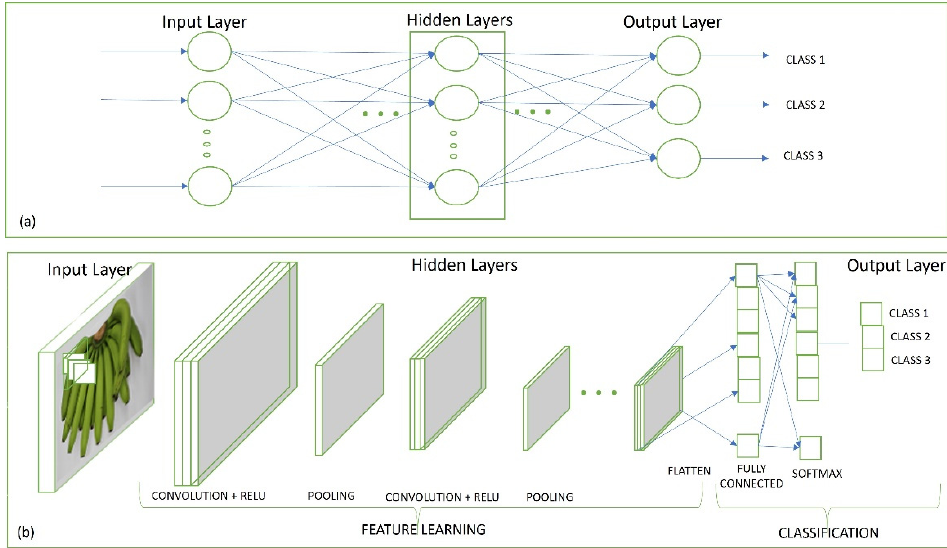
Figure 4. Neural network architecture, ( a ) a simple multilayer perceptron (MLP) architecture, and ( b ) basic convolutional neural network (CNN) architecture.